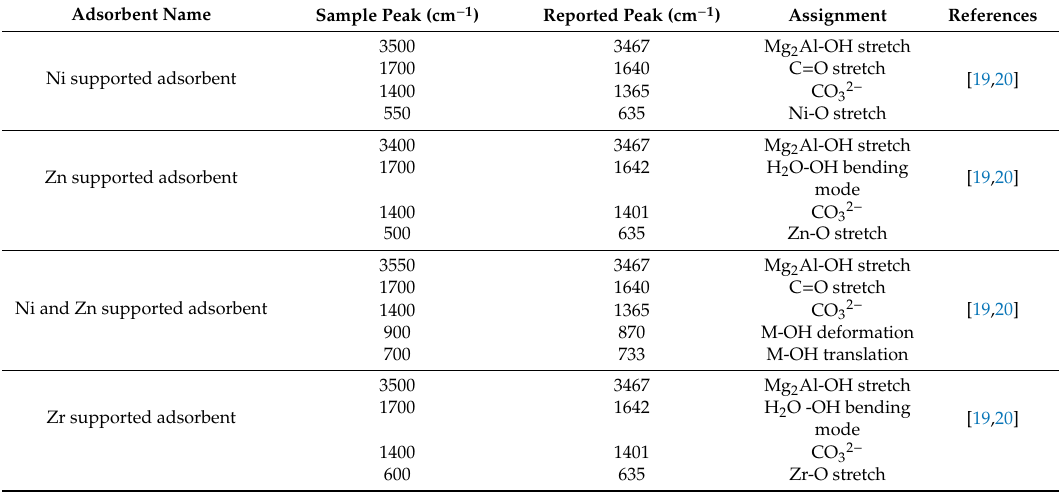
Table 1. Infrared peak of the five